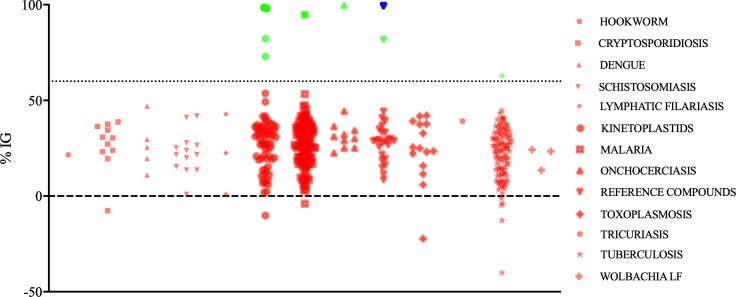
Screening of 400 compounds present in the MMV Pathogen Box® collection against a Fonsecaea pedrosoi strain (CFP00791).Results are presented as the percent inhibition of growth (%IG) of the fungal strain. The compounds tested are grouped according their original application against some infectious diseases, as described by Medicines for Malaria Venture. The dashed line represents the threshold applied in this study to select compounds with anti-chromoblastomycosis activity. Red symbols represent compounds that were discarded, due to low %IG. Green symbols represent compounds selected for further studies. The blue symbol represents the internal control drug posaconazole.